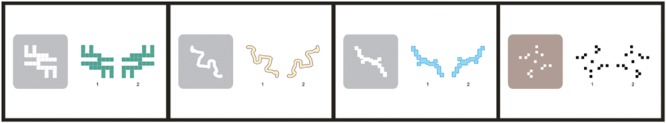
Example items from the Mental Rotation Training Program (MRTP). In all examples, the first stimulus is rotated 180° and the second stimulus is flipped over the X axis with respect to the target.